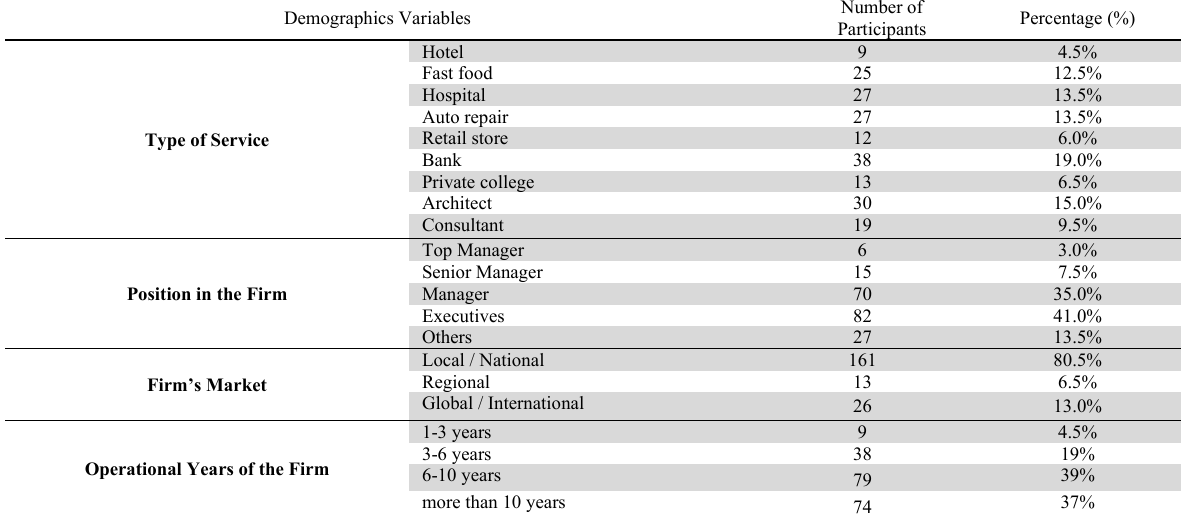
Company Demographic profile for the Study Demographics